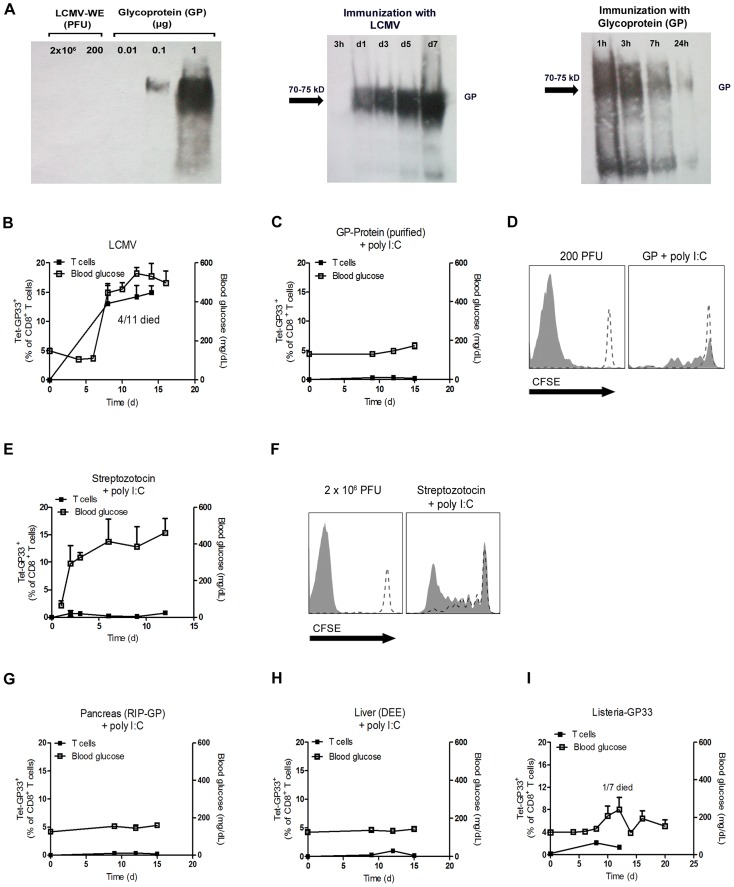
Only replicating antigen is efficient in breaking autoimmune tolerance.(A) Initial LCMV inoculate (2×106 PFU and 200 PFU) and purified LCMV glycoprotein (GP) (0.01, 0.1, 1 µg) were stained for LCMV-GP by Western blot analysis. After immunization of C57BL/6 mice with live LCMV (200 PFU, i.v.) and purified LCMV glycoprotein (GP, 2 µg, i.v.), spleen lysates were analyzed by Western blot for LCMV-GP expression at the indicated time points. (B) RIP-GP mice were infected intravenously with 200 PFU of LCMV-WE. The number of GP33-specific CD8+ T cells was determined by tetramer staining and flow cytometry, and serum glucose concentration was determined at the indicated time points (n = 4–11). (C) RIP-GP mice were immunized intravenously with 2 µg purified LCMV-GP in combination with poly I:C (100 µg). The number of autoreactive CD8+ T cells was determined by tetramer staining and flow cytometry, and serum glucose concentration was determined at the indicated time points (n = 4). (D) 107 Splenocytes from P14/CD45.1 mice were labeled with CFSE and adoptively transferred into C57BL/6 mice. After 24 hours, C57BL/6 mice were left uninfected (both histogram blots, dotted line) or infected with 200 PFU LCMV-WE (left histogram blot, filled area) or immunized with 2 µg LCMV-GP (n = 3, right histogram blot, filled area). Proliferation of CD45.1+CD8+ T cells was assessed by CFSE dilution in spleen 6 days after transfer. Histograms show cells gated on CD45.1+ CD8+ T cells. One representative set of data is shown. (E) RIP-GP mice were treated intraperitoneally with Streptozotocin (5 mg) and intravenously with poly I:C (100 µg). The number of islet-specific CD8+ T cells was determined by tetramer staining and flow cytometry, and serum glucose concentration was determined at the indicated time points (n = 3). (F) 107 Splenocytes from P14/CD45.1 mice were labeled with CFSE and transferred into RIP-GP mice or C57BL/6 mice. After 24 hours, RIP-GP mice were treated either left untreated (right histogram blot, dotted line) or were treated intraperitoneally with 5 mg Streptozotocin and intravenously with poly I:C (100 µg, right histogram blot, filled area). C57BL/6 mice were either left untreated (left histogram blot, dotted line) or infected with 2×106 PFU LCMV (left histogram blot, filled area). Proliferation of CD45.1+CD8+ T cells was assessed by CFSE dilution in the spleen 6 days after transfer (n = 3). Blots show cells gated on CD45.1+ CD8+ T cells. One representative set of data is shown. (G) RIP-GP mice were immunized intraperitoneally with homogenized pancreas (40 mg) from RIP-GP mice and intravenously with poly I:C (100 µg). The number of islet-specific CD8+ T cells was determined by tetramer staining and flow cytometry, and serum glucose concentrations were determined at the indicated time points (n = 4). (H) RIP-GP mice were immunized intraperitoneally with homogenized liver derived from DEE mice (100 mg) and immunized intravenously with poly I:C (100 µg). The number of islet-specific CD8+ T cells was determined by tetramer staining and flow cytometry, and serum glucose concentration was determined at the indicated time points (n = 4). (I) RIP-GP mice were infected with 103 CFU of Listeria-GP33 intravenously. Number of islet-specific CD8+ T cells was determined by tetramer staining and flow cytometry, and serum glucose concentration was measured at the indicated time points (n = 4–7).